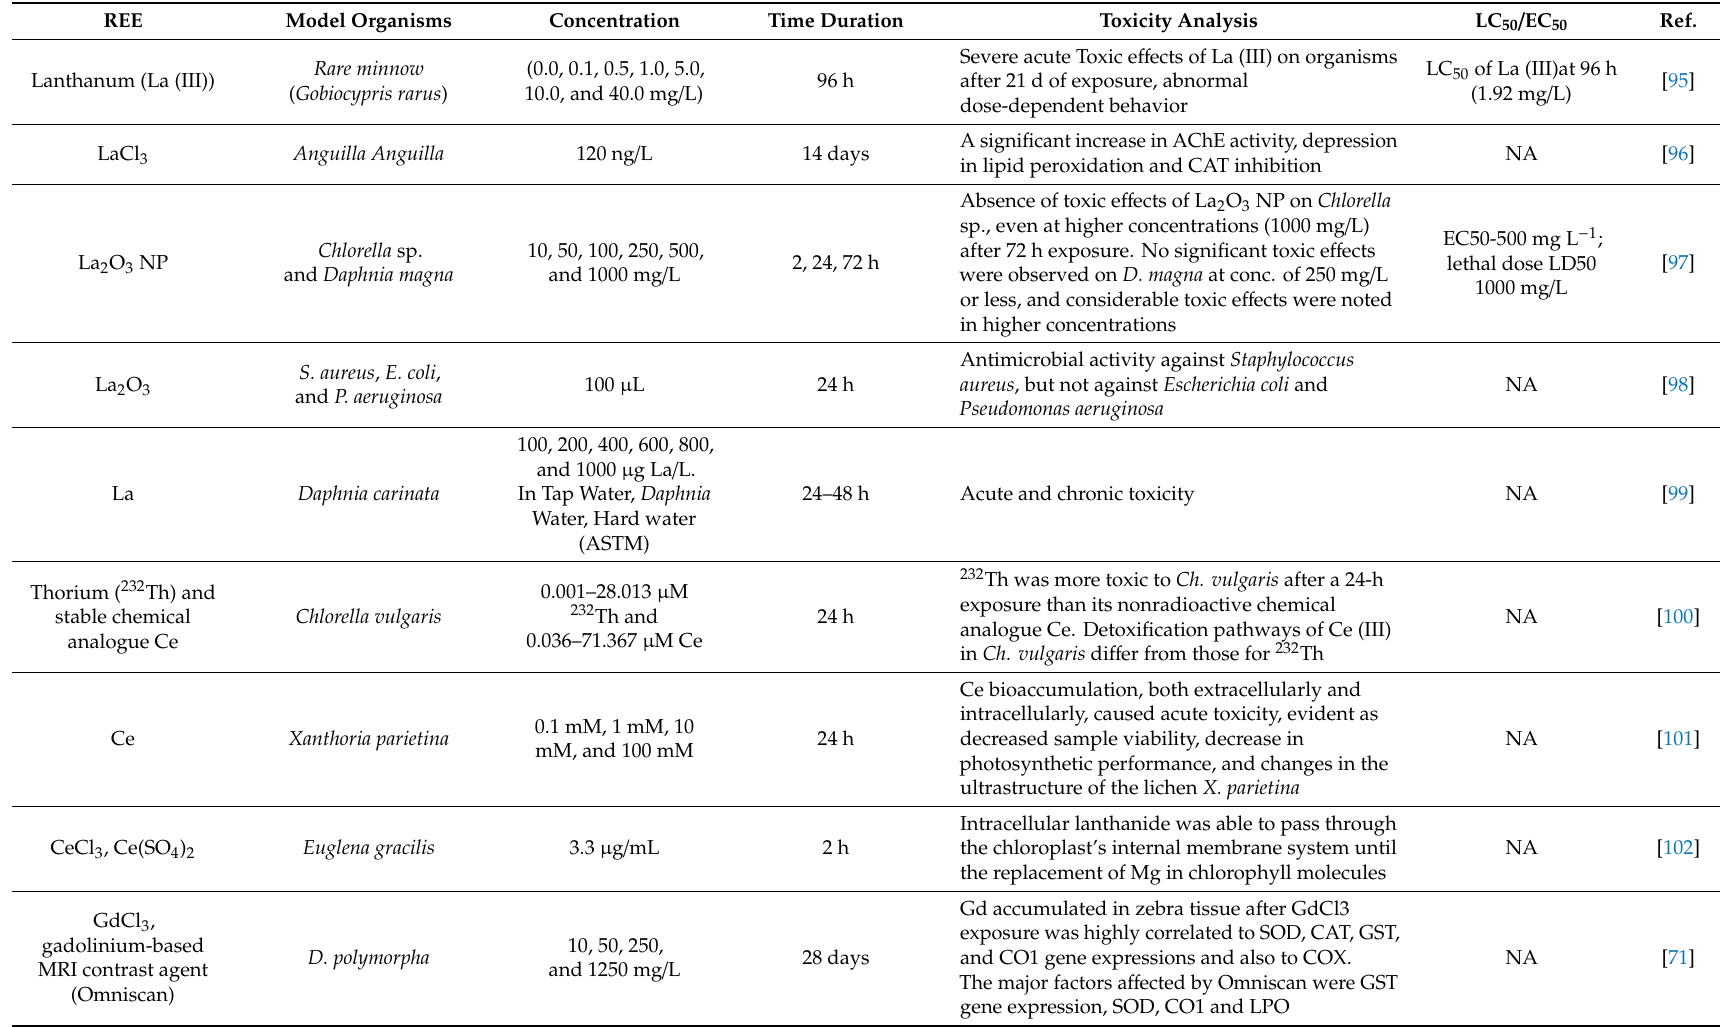
Table 3. The summary of the e ff ects of individual rare earth elements